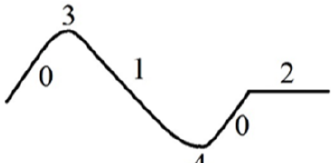
Figure 3. Symbolization of a spectral curve. (Ascending segment: 0, descending segment: 1, flat segment: 2, and peak and valley of the spectral curve: 3 and 4, respectively).